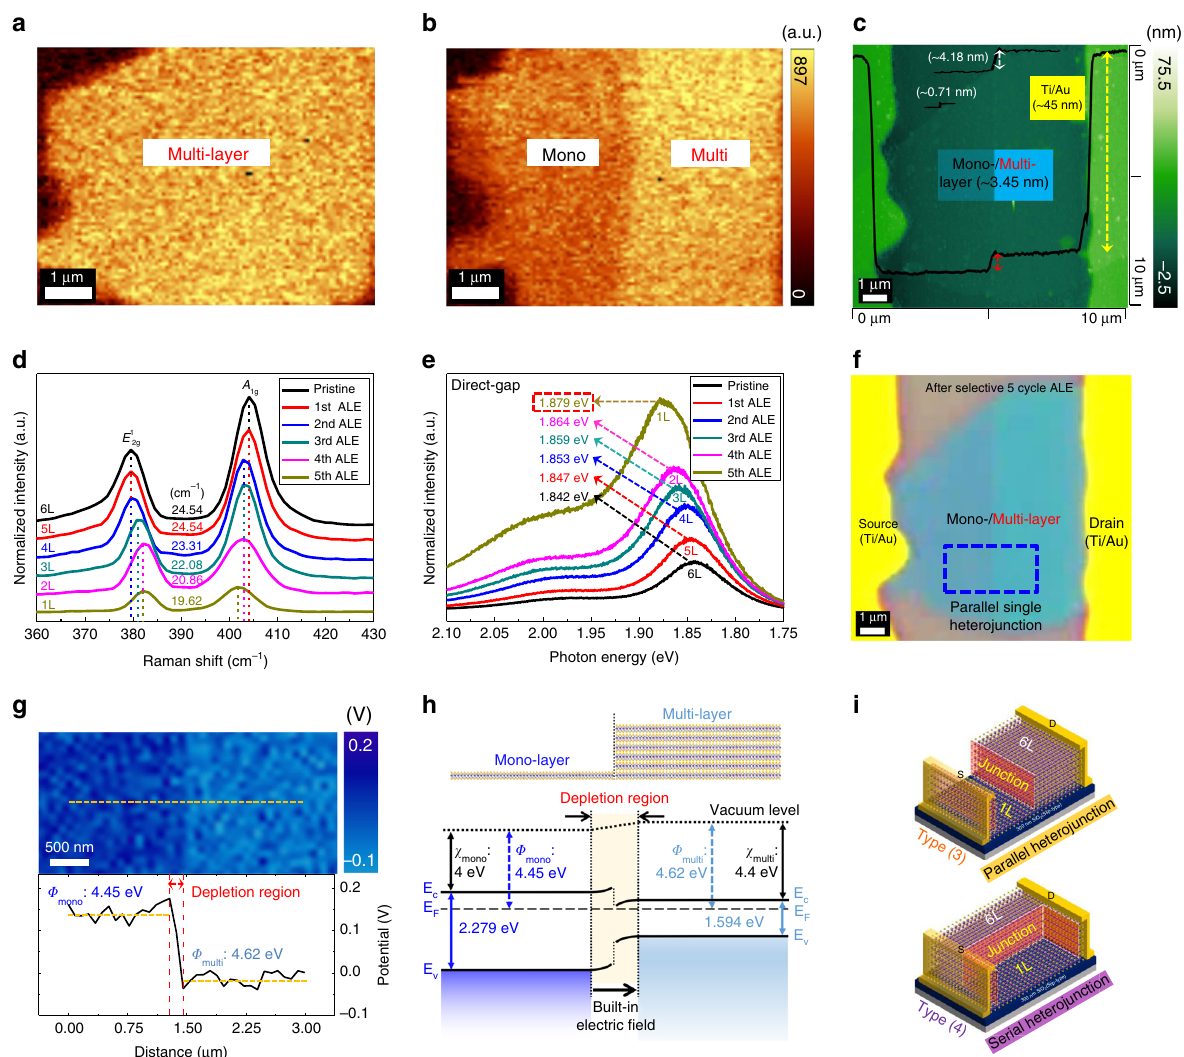
Fig. 1 Characterization of heterojunction MoS 2 formed by the ALE technique. Raman mapping images of multi-layer MoS 2 a pristine 6L-MoS 2 and b the mono-/multi-layer (6 L) MoS 2 heterojunction after selective 5 cycles of atomic layer etching (ALE) for the left side of the 6L-MoS 2 . c Atomic force microscopy (AFM) thickness analysis for the heterojunction in b . d Raman and e photoluminescence (PL) spectra analysis for 1 to 5 cycles of ALE on pristine 6L-MoS 2 . f Optical microscopic (OM) image of the mono-/multi-layer heterojunction device. g Kelvin probe force microscopy (KPFM) analysis of the mono-/multi-layer heterojunction area (blue box) of the OM image (as shown in f ). h Band diagram for the mono-/multi-layer (6L) heterojunction. i The schematic drawing of the MoS 2 fi eld effect transistors (FETs) for parallel heterojunction [Type (3)] and serial heterojunction [Type (4)] Parallel- and serial-type nano-bridge multi-heterojunction by differences in work function 38 , electron af fi nity 38,39 , and the selective ALE . To study the effect of different MoS electronic band-gap 40 . Due to the built-in electric fi eld in the 2 -based depletion region of the heterojunction, when a light is irradiated, heterojunctions on the optoelectronic performances of back-gated the photogenerated holes in the mono-layer and multi-layer MoS 2 FETs (photodetectors), in addition to the above parallel- MoS 2 go to the multi-layer MoS 2 region while the photogener- and serial-heterojunctions named as Type (3) and Type (4), ated electrons in the multi-layer MoS 2 are trapped at the parallel nano-bridge type [Type (5)] and serial nano-bridge type [Type (6)] mono-/multi-layer heterojunctions were formed interface and the photogenerated electrons in the mono-layer through the selective ALE after patterning the multi-layer MoS 2 MoS 2 stay in the same region away from the interface. Therefore, with a nano-patterning process [using a solvent-assisted nano- more photocarriers are expected in the MoS 2 channel by the transfer printing (S-nTP) process] 41 . Figure 2a shows the side- enhanced generation of electron – hole pairs compared with the view fi eld emission-scanning electron microscopy (FE-SEM) case of channel without the heterojunction. Figure 1i shows image of SiO 2 patterns formed on the 6L-MoS 2 by the nano- the schematic drawing of two different mono-/multi-layer MoS 2 heterojunctions that can be formed on 6L-MoS 2 FETs by PR patterning process. 18.1 nm thick SiO 2 line patterns with 50 nm patterning parallel/vertical to the source/drain edges and intervals and the line width of 25 nm could be seen. (In the S-nTP removing 5L-MoS 2 selectively as parallel- and serial-type process, for the linear alignment of SiO 2 line nano-patterns, a heterojunctions named as Type (3) and Type (4), respectively. guideline shown as white dots which was not patterned with the [Type (1) is the MoS 2 FET with a mono-layer MoS 2 channel and SiO 2 nano-patterns was required). Figure 2b, c are the top-view Type (2) is the FET with a multi-layer (6L) MoS 2 channel]. FE-SEM images of SiO 2 line nano-patterns showing that the NATURE COMMUNICATIONS| (2019) 10:4701